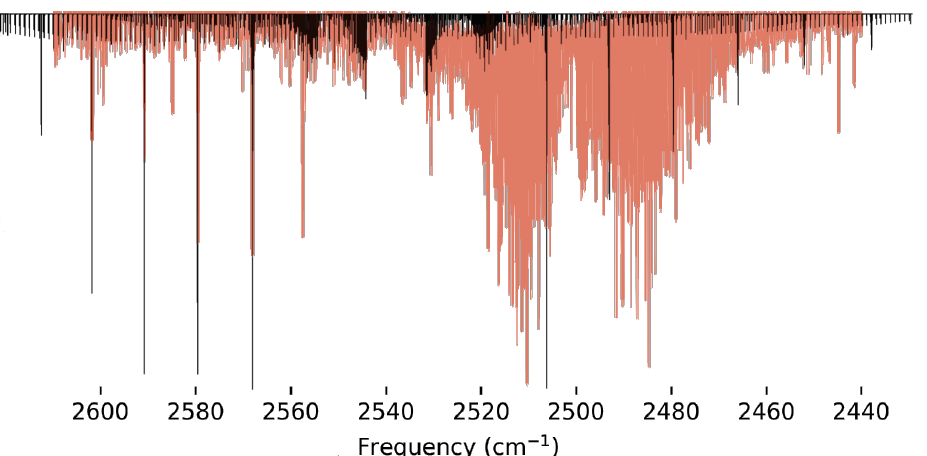
Figure 3. Simulated IR spectrum (black) of the S–H stretch for HOSH with the gas-phase IR spectrum from [73] (red) of the same mode containing the contamination from the ( ν 1 + ν 3 ) combination